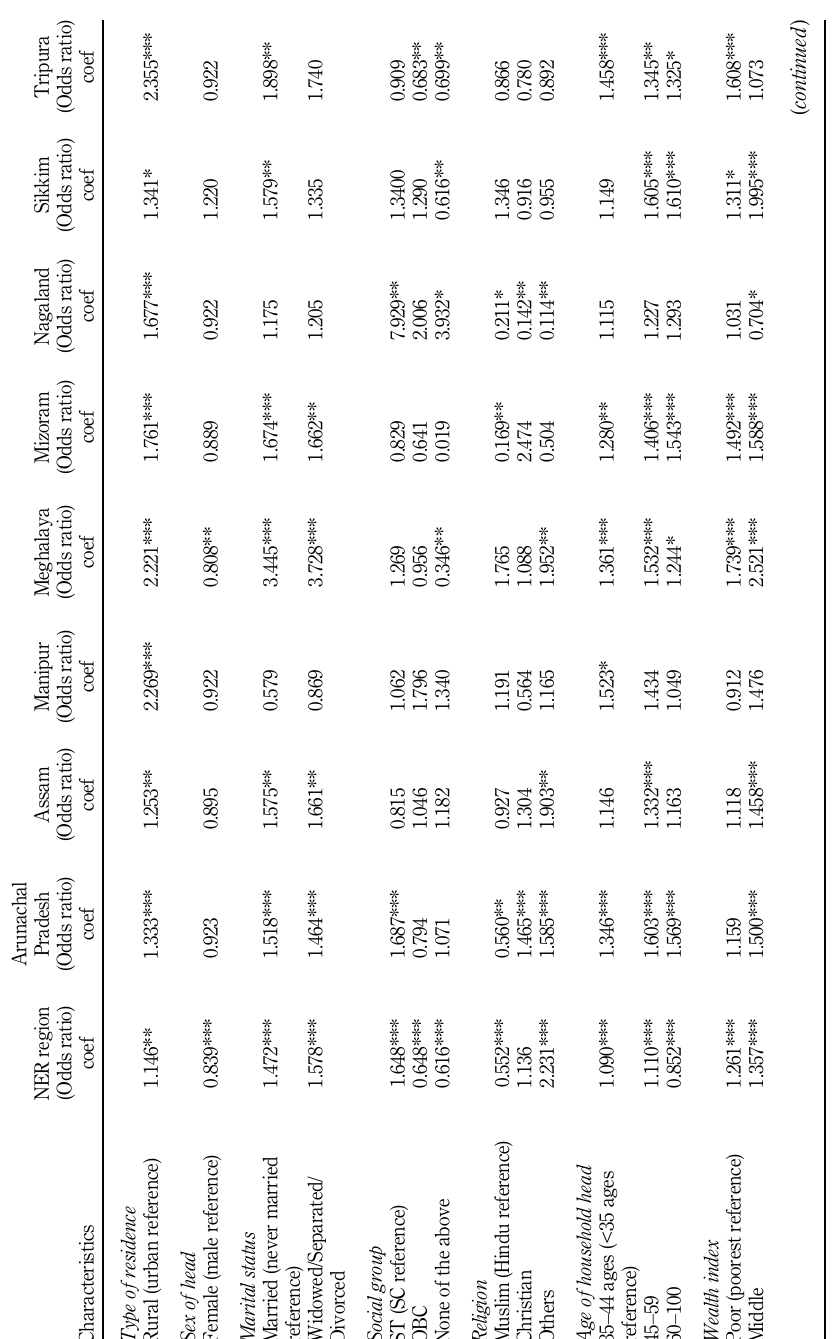
Table 3. Multivariate analysis using logistic